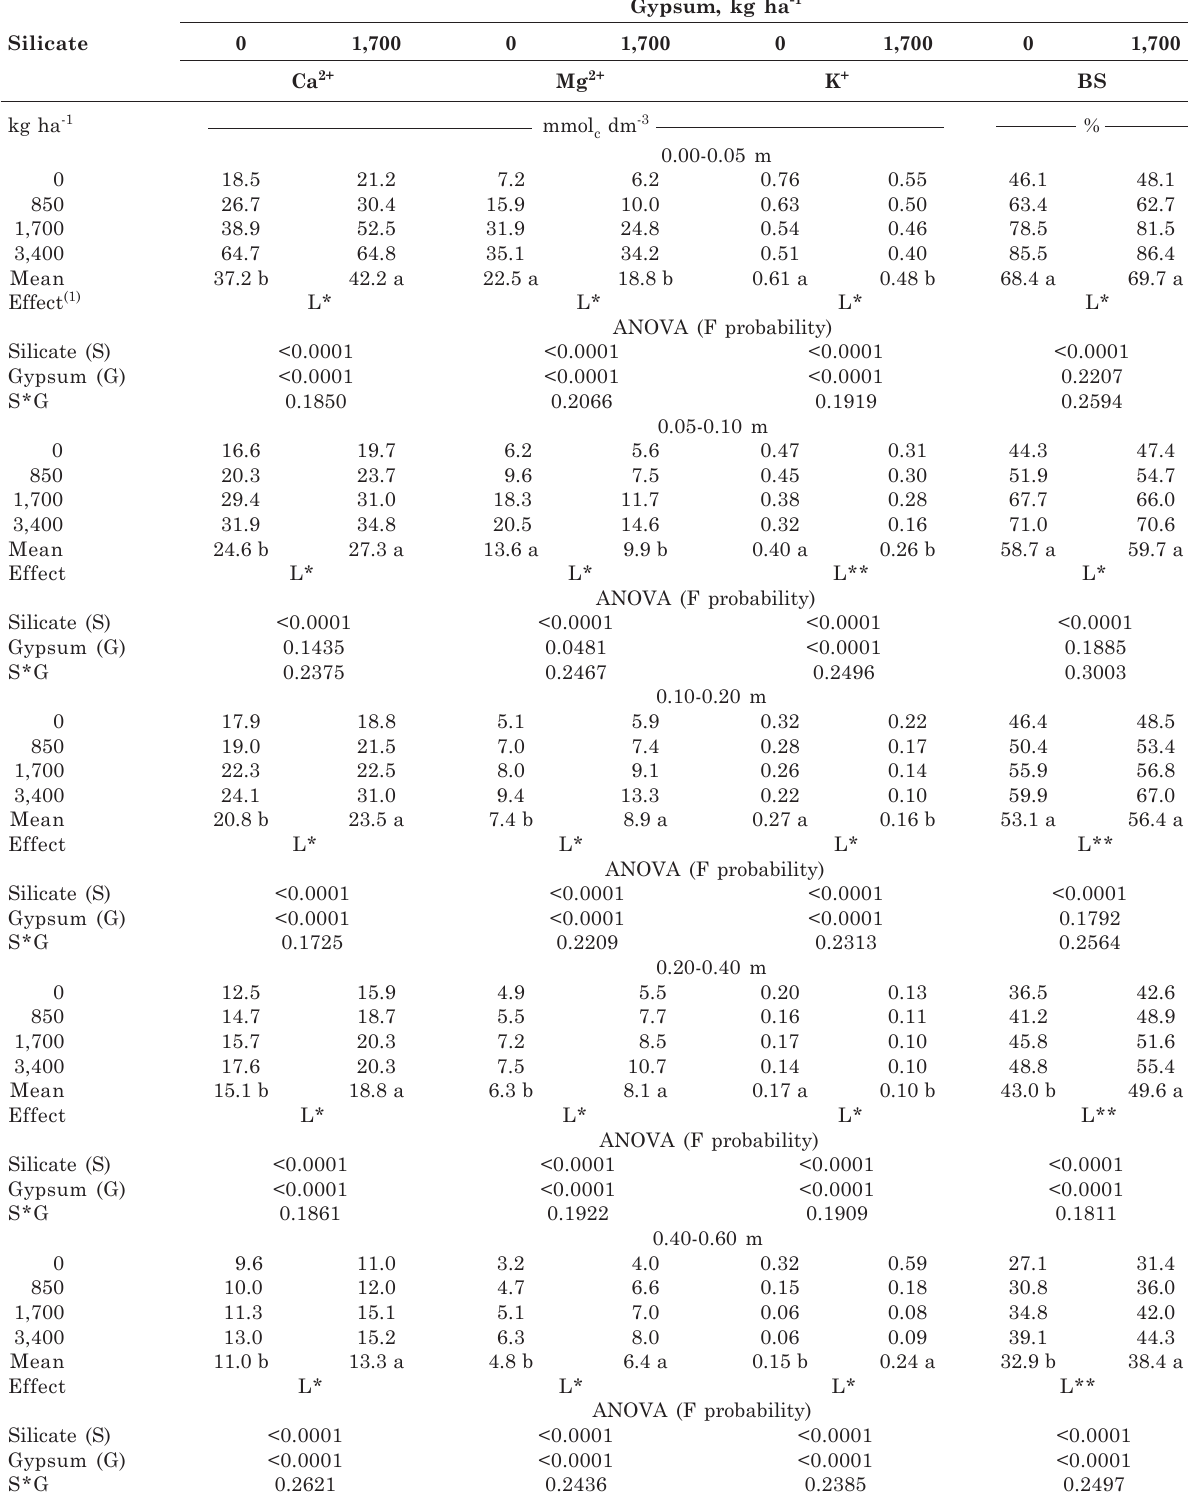
Table 2. Values of exchangeable Ca 2+ , Mg 2+ , and K + , and base saturation (BS) of soil samples taken 12 months after Ca-Mg silicate and gypsum surface application on green sugarcane, and ANOVA significance at five soil